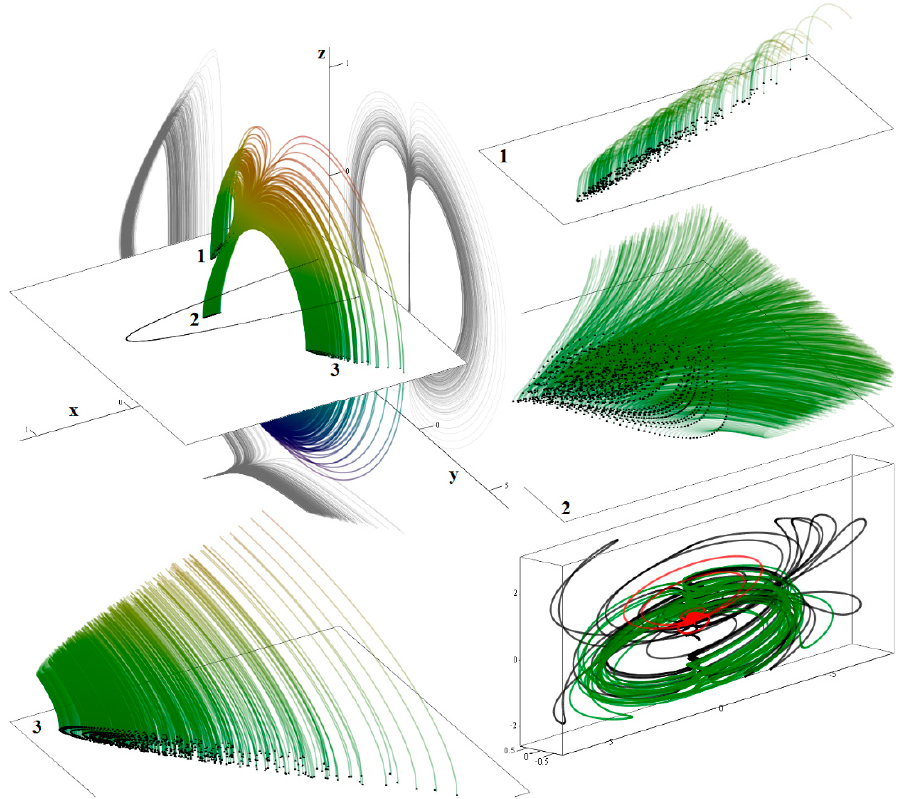
Figure 1. A 3D perspective of a typical chaotic attractor system with hyperbolic equilibrium; Poincaré section in z = 0 and three associated return maps; sensitivity to changes in initial conditions with a coordinate difference Δ x = 10 − 4 (black), Δ y = 10 − 4 (green), Δ z = 10 − 4 (red), final iteration time 50 and an equal scaled axis system.